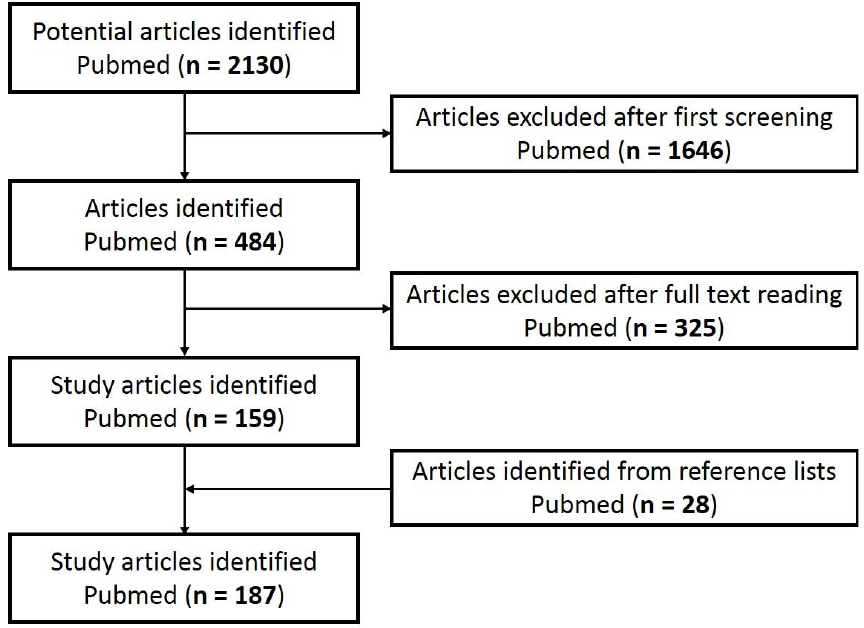
Figure 1. Flowchart of article screening.